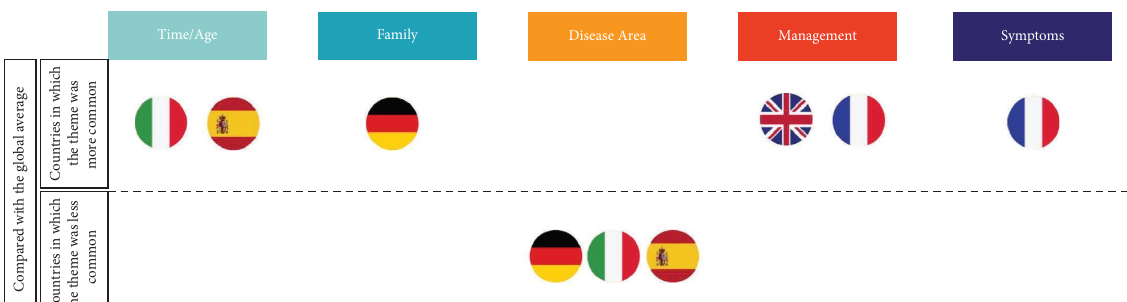
Figure 4: Country diferences: how themes in each country compared with the overall global